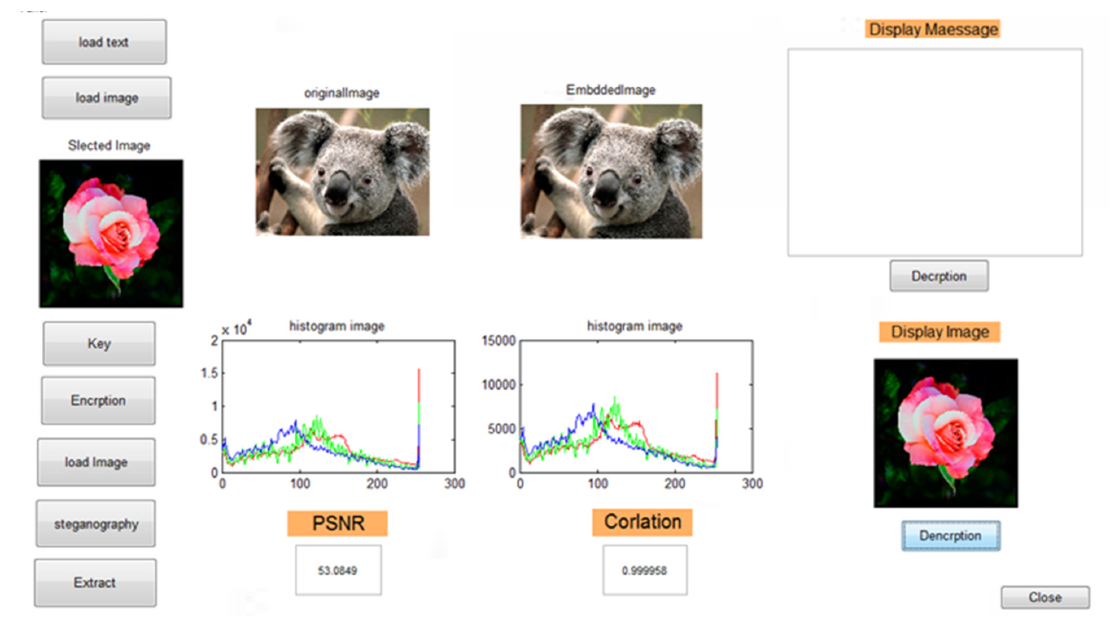
Fig. 3. Interactive display screen for the proposed system.